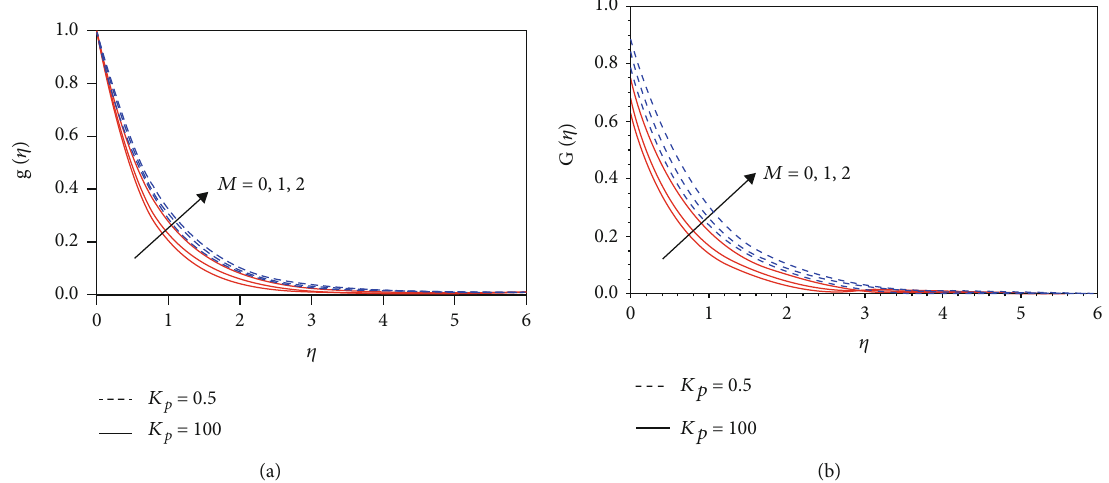
= Ec = 0 : 1, f = 0, Pr = 2 and Q = Rd = 0 : 2 : (a) g in the PST case 1 w